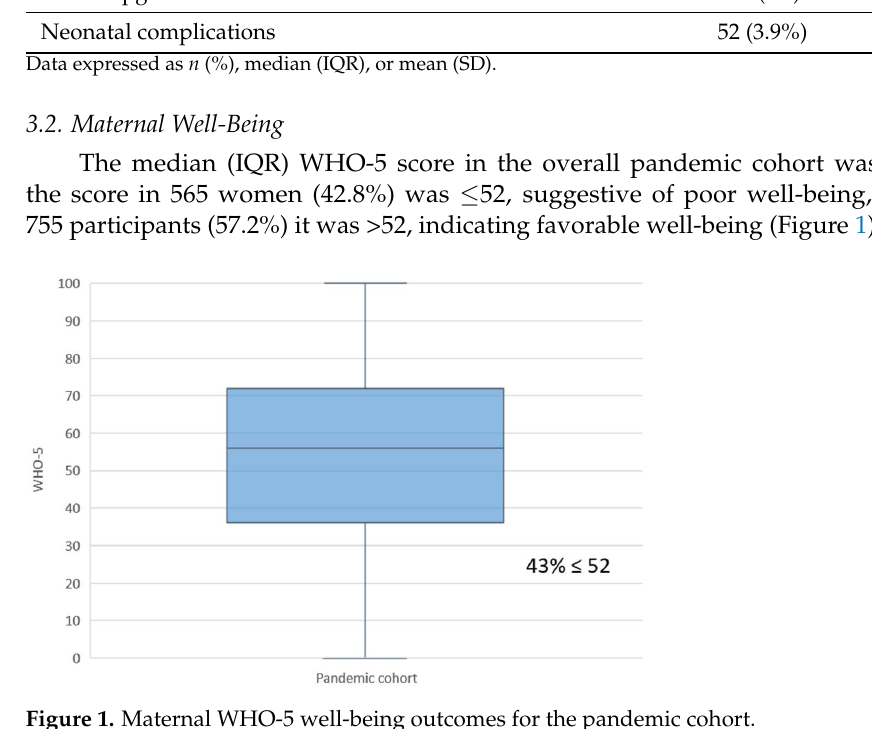
Figure 1. Maternal WHO-5 well-being outcomes for the pandemic cohort.